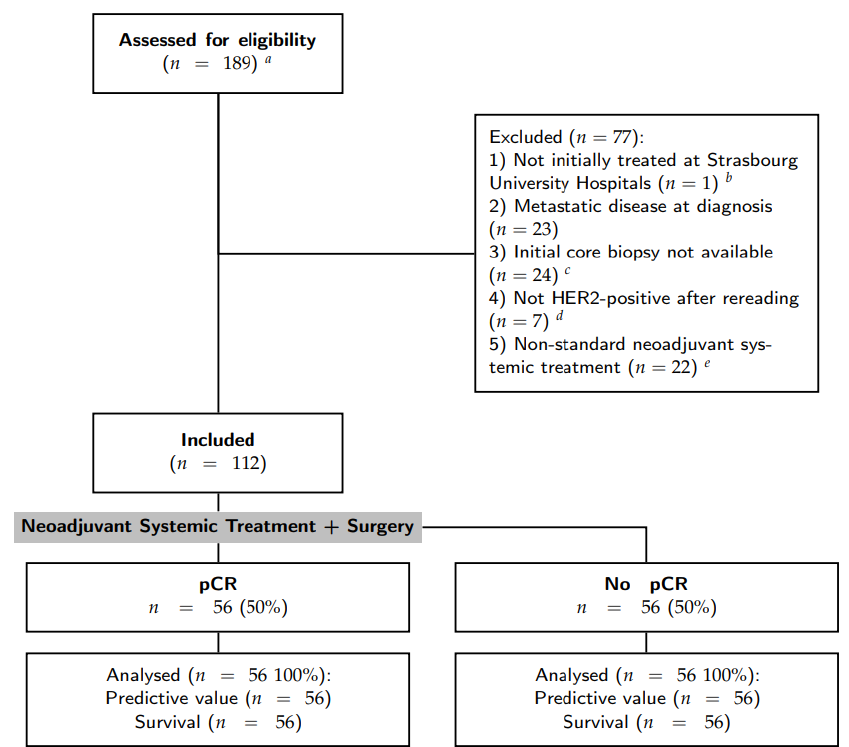
Figure 1. Flow chart of patient selection. a The initial query was all breast specimens HER2+ treated by surgery; b one patient was excluded as it was a second pathology opinion after a surgery in another center; c some initial core biopsies were stored in other pathology laboratories. Requests for stored material in other laboratories were made 3 times, some were recovered but others were not available or did not have residual material to perform immunohistochemistry assays; d either HER2 score 0–1 or 2+ with non-amplified in situ hybridization; e without anthracyclines and/or with